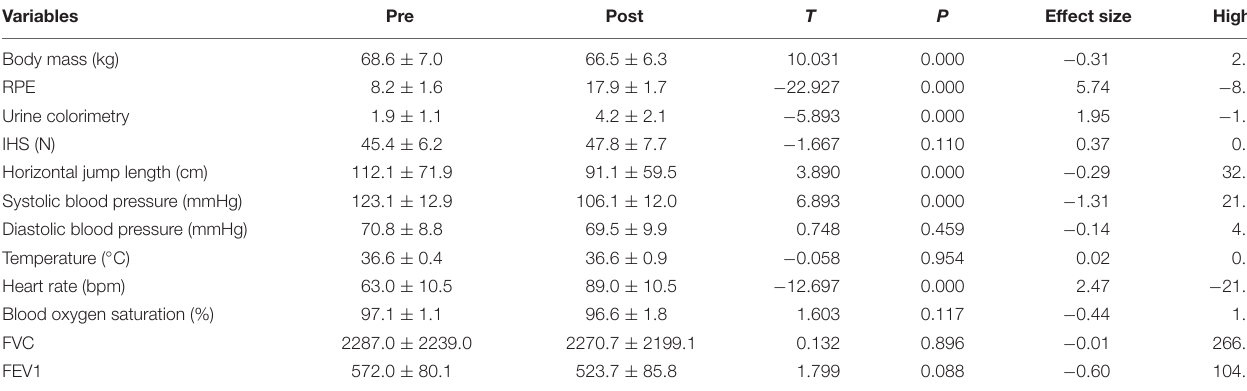
TABLE 4 | Modification of study variables before and after the ultraendurance